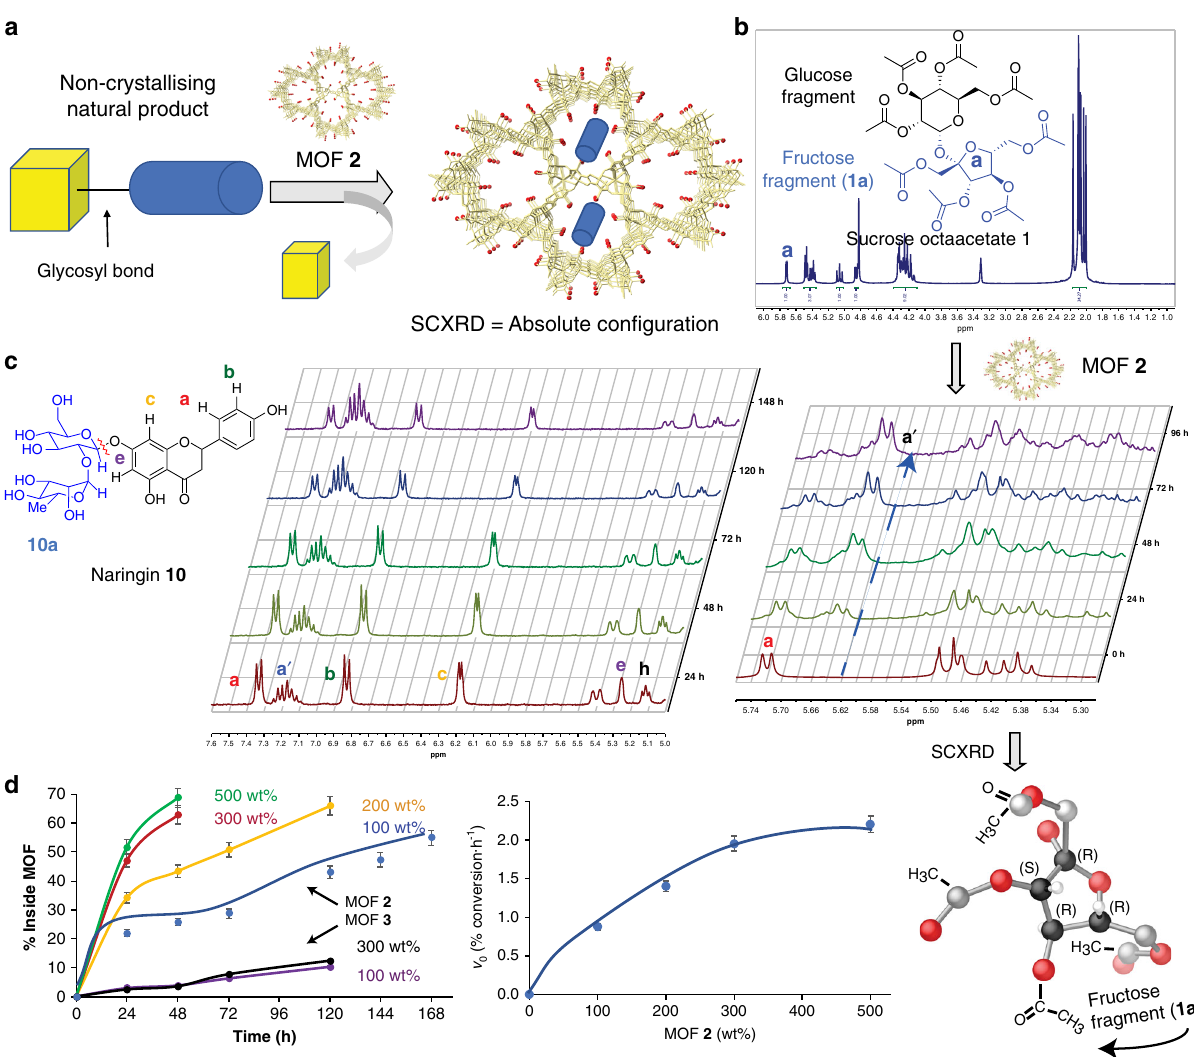
Fig. 1 MOF-catalyzed selective hydrolysis of glycosyl bonds of sucrose 1. a Schematic representation of the one-pot selective hydrolysis/adsorption/ crystal resolution of a natural product within a MOF. b 1 H NMR spectra of sucrose 1 before and after selective hydrolysis with MOF 2 , and SCXRD resolution of fructose fragment 1a . c Evolution with time of naringin 10 in CD 3 CN after reaction with MOF 2 at 60 °C, followed by 1 H NMR. d Hydrolysis and incorporation of the alkyl part of naringin 10 into MOF 2 or MOF 3 with time for different amounts of MOFs (left) and initial rate as a function of the amount of MOF 2 employed (right), according to 1 H NMR integrations. Reaction rates were measured with the initial points up to 30% conversion. Lines are a guide to the eye. Error bars account for a 5%